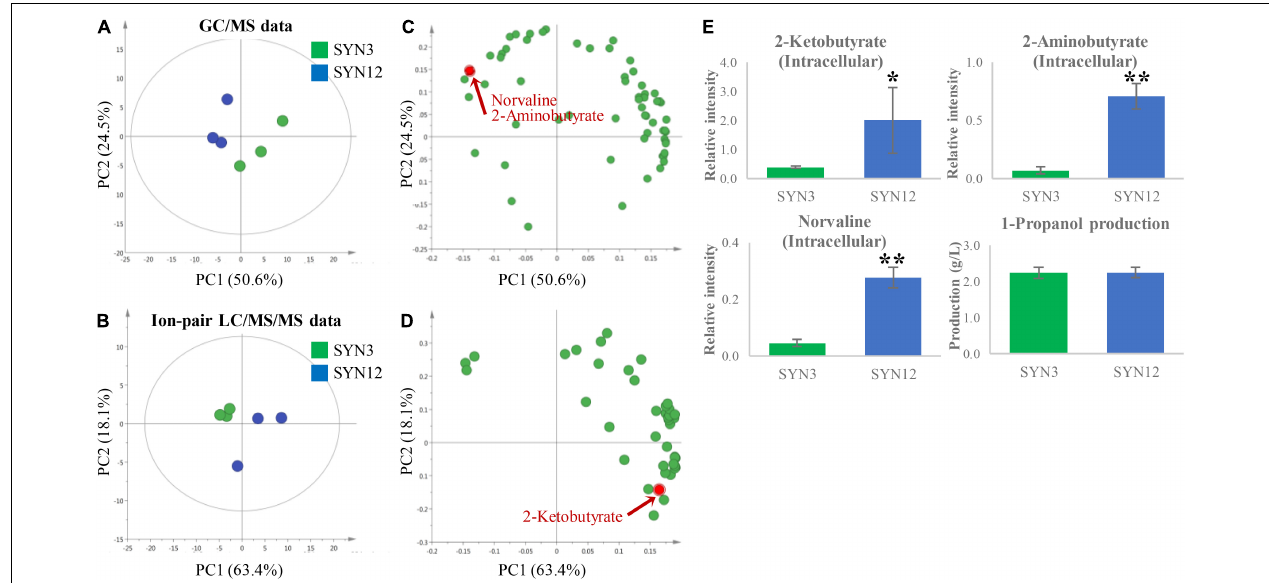
FIGURE 2 | PCA analysis of SYN3 and SYN12. The score plot derived from autoscaled (A) GC/MS data. (B) Ion-pair LC/MS/MS data. The corresponding loading plot illustrating metabolites that contributed to the separation on PC1 and PC2 derived from autoscaled. (C) GC/MS data. (D) Ion-pair LC/MS/MS data. All metabolites contribution is shown in Supplementary Figure 1 . (E) The result of intracellular key intermediate, by-products and 1-propanol production. Metabolite intensities shown in the y -axis were normalized to an internal standard. Asterisks indicate significant difference from the strain (* p < 0.05, ** p < 0.01). The error bars indicate standard deviations obtained from three replicate